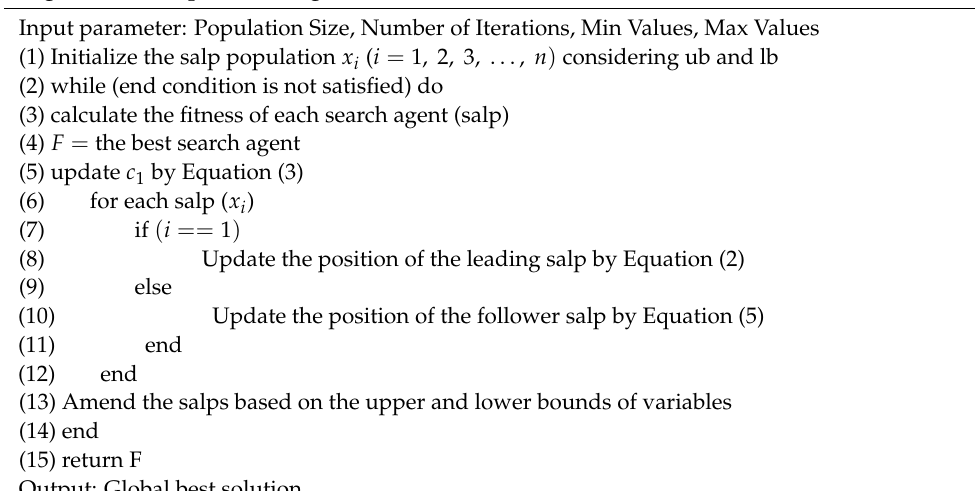
Algorithm 1. Salp Swarm